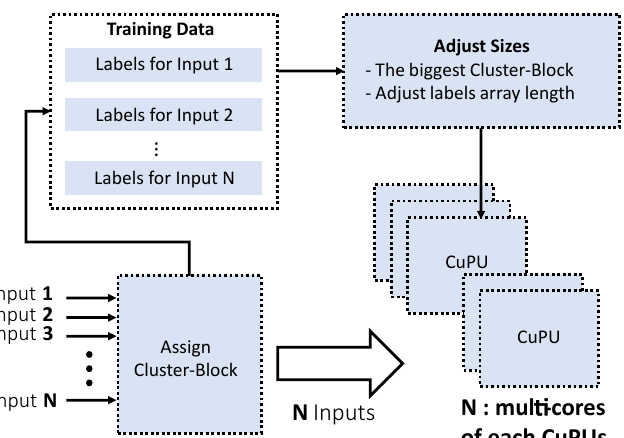
Figure 5. Hardware architecture for the implementation of the modified KNN algorithm. New blocks were added to the original KNN